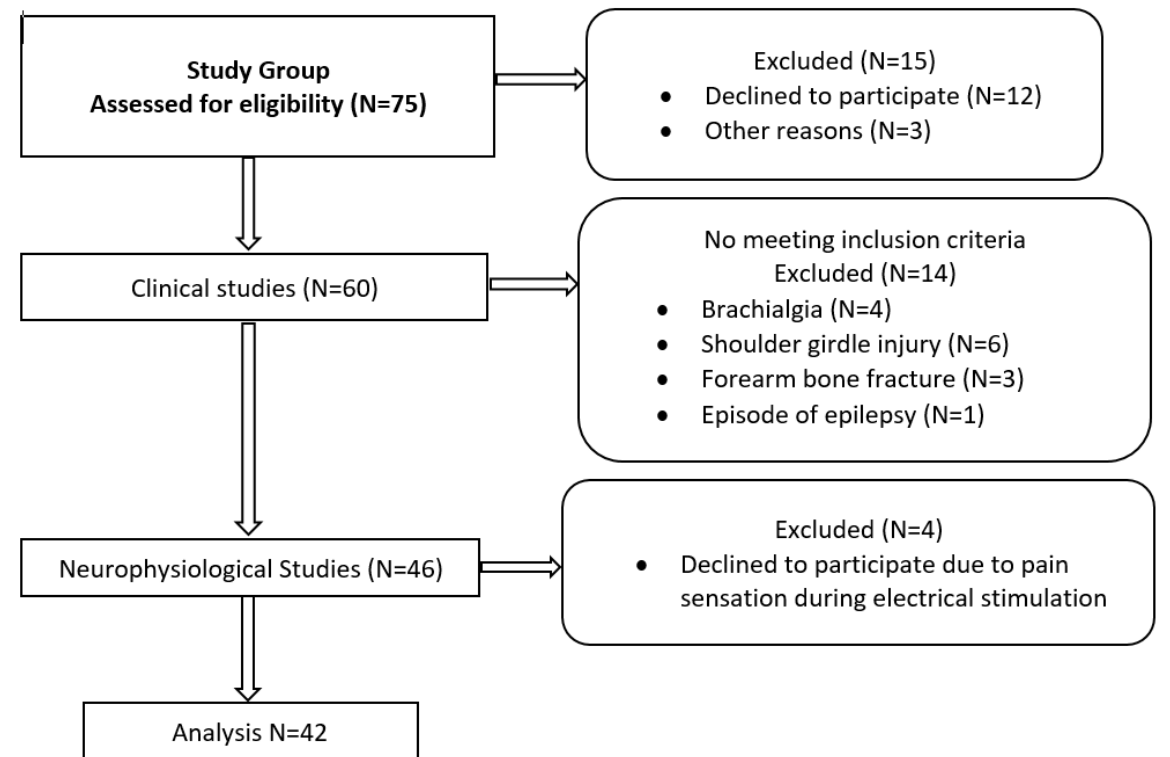
Figure 1. Flowchart of clinical and neurophysiological study algorithm. Table 1. Data on demographic and anthropometric characteristics of subjects included in research group. Ranges, mean values, and standard deviations are presented.